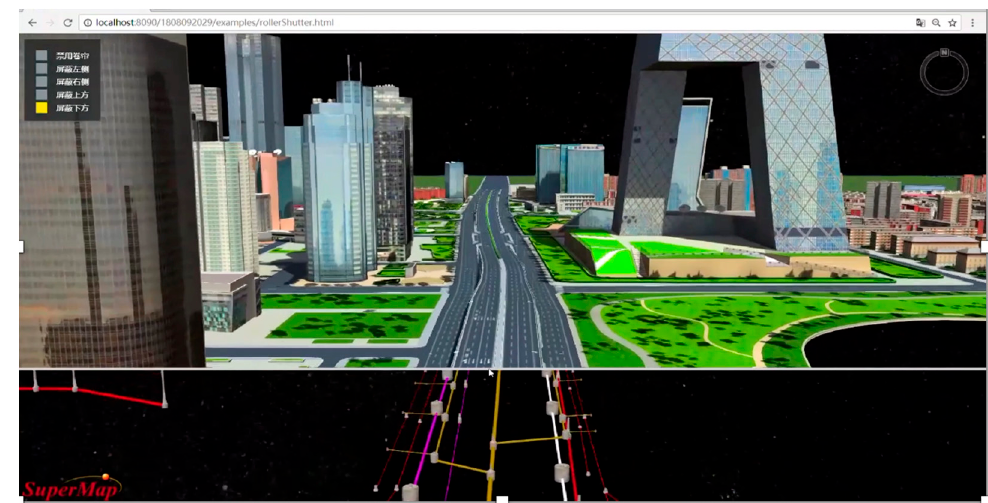
Figure 12. Pipeline network model in iDesktop Cross.